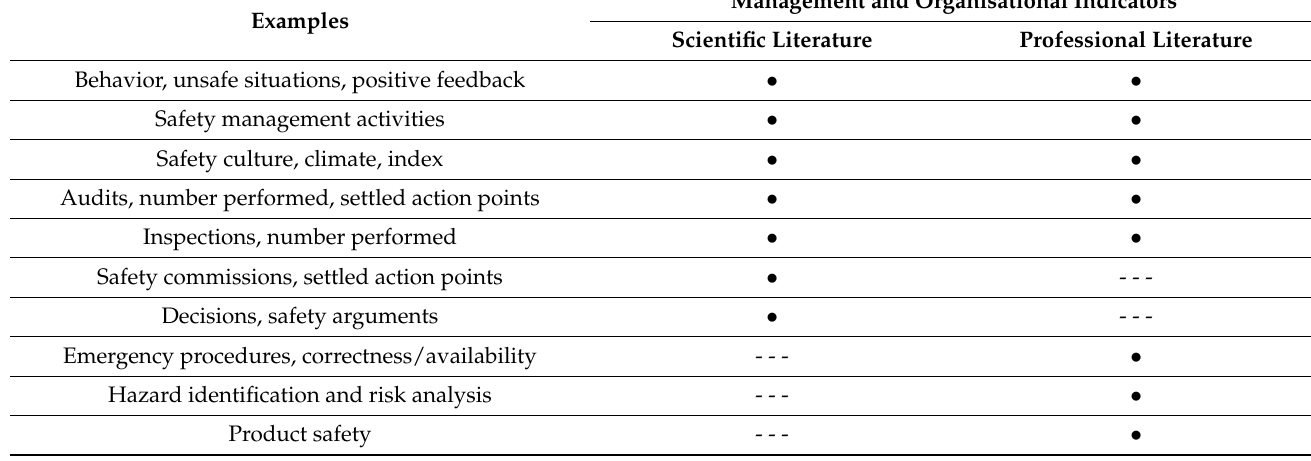
Table 3. Examples of management and organizational indicators from the scientific and professional literature (Adapted from